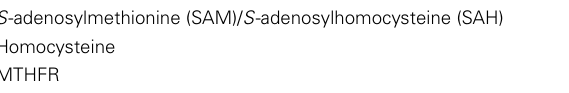
Table 4 | Methylation biomarkers inASD (see text for references) .